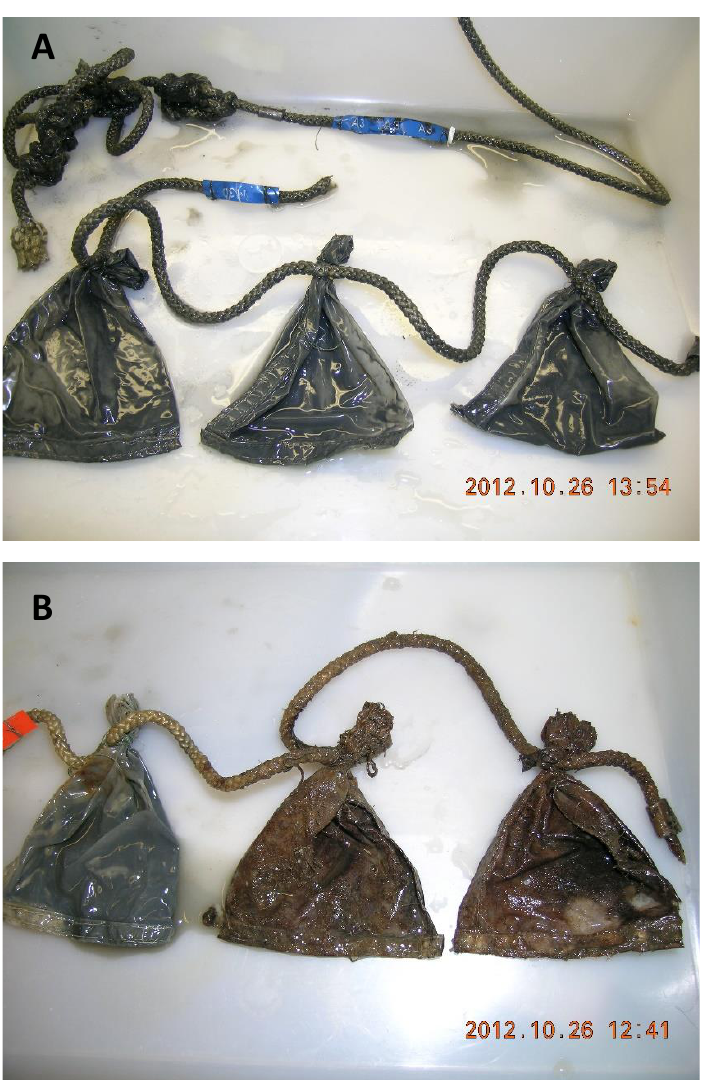
Figure 4. Bags from the anoxic ( A ) and oxidized ( B ) environments.